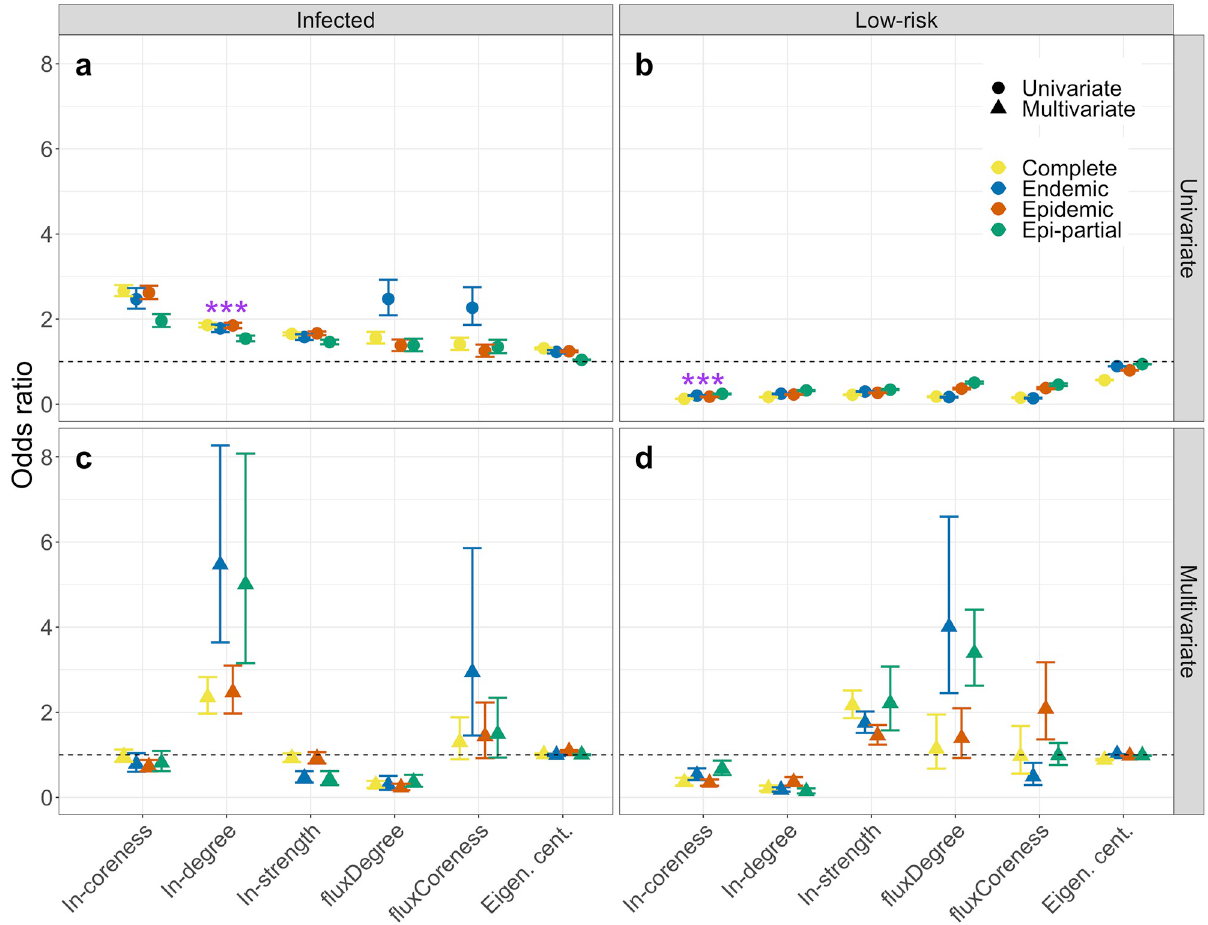
outbreaks is similar to the number of outbreaks in the whole endemic region). The best univariate predictor (based on BIC) is indicated with “ ��� ” in panels ( a and b ). Results for each independent serotype in Section G in S1